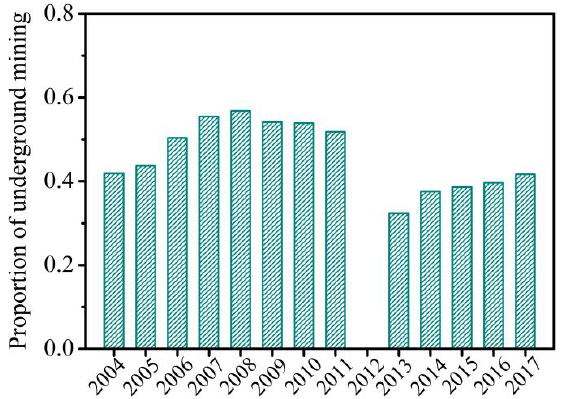
Figure 7. Proportion of copper ore underground mining from 2004 to 2017.